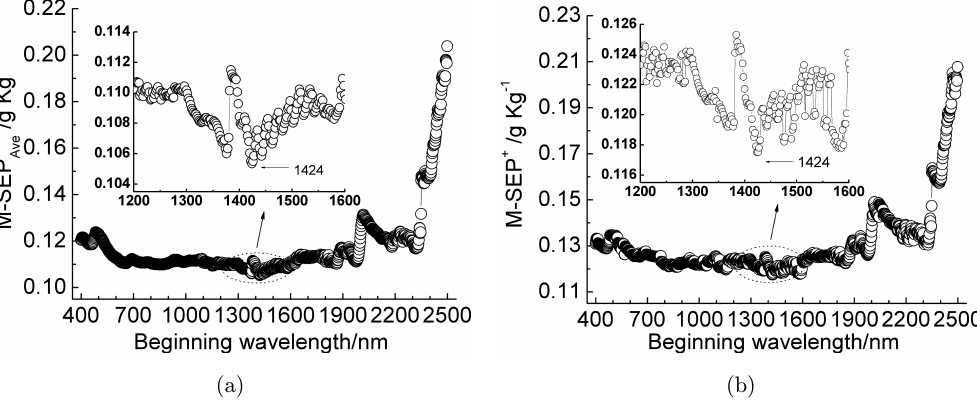
Fig. 5. M-SEP Ave and M-SEP þ of the local optimal model for each beginning wavelength: (a) M-SEP Ave and (b) M-SEP þ